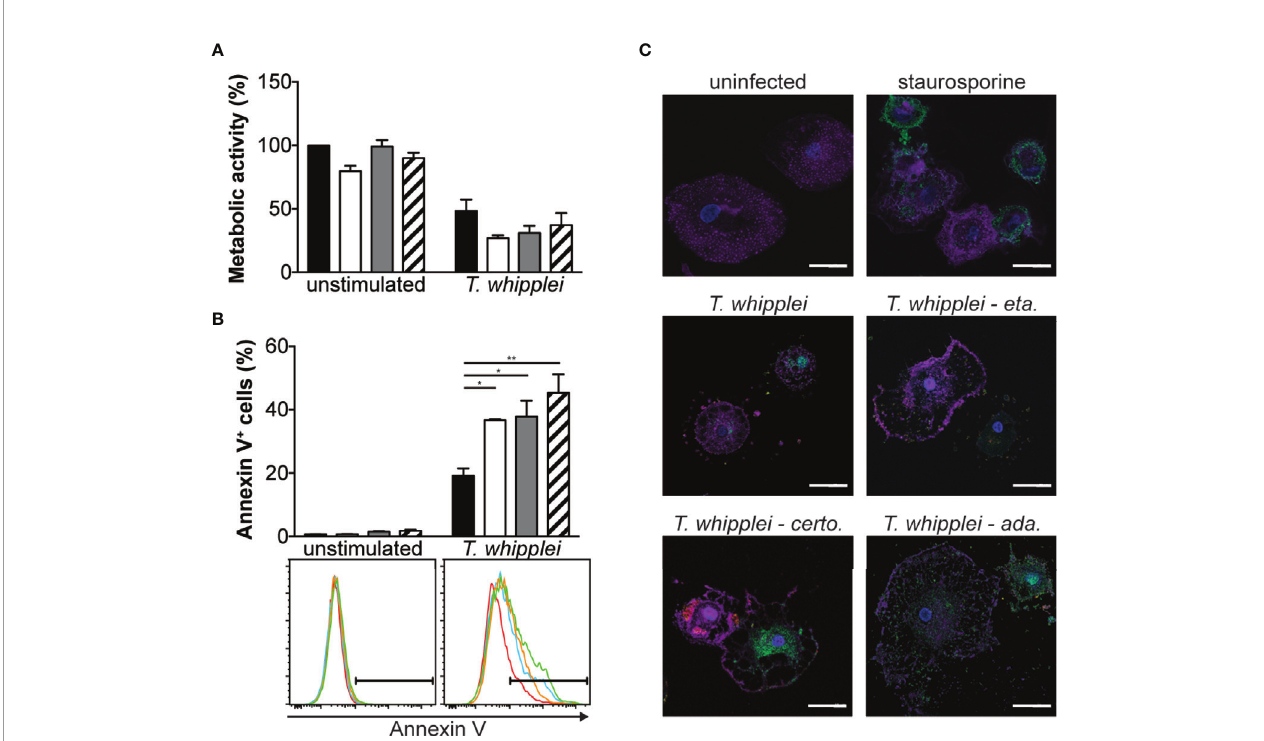
FIGURE 3 | TNFI increase T. whipplei-induced macrophage apoptosis. (A) Macrophages were infected or not with T. whipplei (50 bacteria per cell) alone (black bars) or in the presence of etanercept (white bars), certolizumab (grey bars) or adalimumab (hashed bars) for 24 h. Cell metabolic activity was assessed by MTT assay and expressed as % of uninfected and untreated cells (N = 3). (B) THP-1 macrophages were infected or not with T. whipplei (50 bacteria per cell) alone (black bars) or in the presence of etanercept (white bars), certolizumab (grey bars) or adalimumab (hashed bars) for 24 h. Apoptosis was assessed by fl ow cytometry after annexin V staining (N = 3). Representative plots are shown (red line: untreated; blue line: etanercept; orange line: certolizumab and green line: adalimumab). (C) Macrophages were infected or not with T. whipplei (50 bacteria per cell) alone or in the presence of etanercept (eta.), certolizumab (certo.) or adalimumab (ada.) for 24 h. As a positive control, cells were treated with staurosporine for 4 h. Representative pictures of macrophages stained with anti-active caspase-3 antibody (green), phalloidin (purple) and DAPI (blue) are shown (scale bar = 20 m m). Values represent mean ± standard error of the mean. * and ** P < 0.05 and 0.01, respectively by two-way ANOVA and the Tukey ’ s test for post-hoc